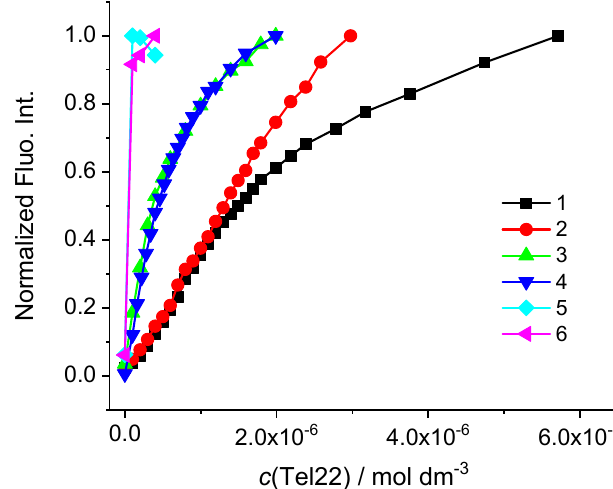
Figure 4. Changes of fluorescence emission of 1–6 ( c = 2 × 10 − 7 mol dm − 3 ) normalized to the last titration point (the highest emission intensity) upon the addition of Tel22 (sodium cacodylate buffer, I = 0.1 mol dm − 3 , pH = 7.0).